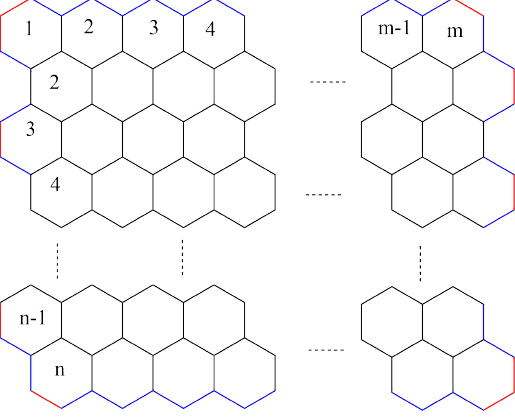
Fig. 1 Graphene sheet G ( n , m ) where, n and m denotes the number of hexagons in rows and columns.